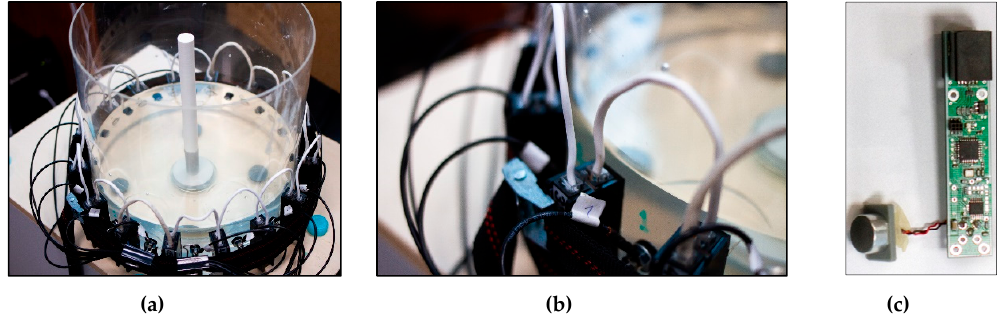
Figure 3. Research object: ( a ) tank with central inclusion, ( b ) connected electrodes and transducers, ( c ) inside the UST transducer.